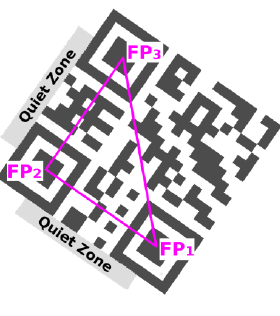
Figure 11. Quiet Zones.